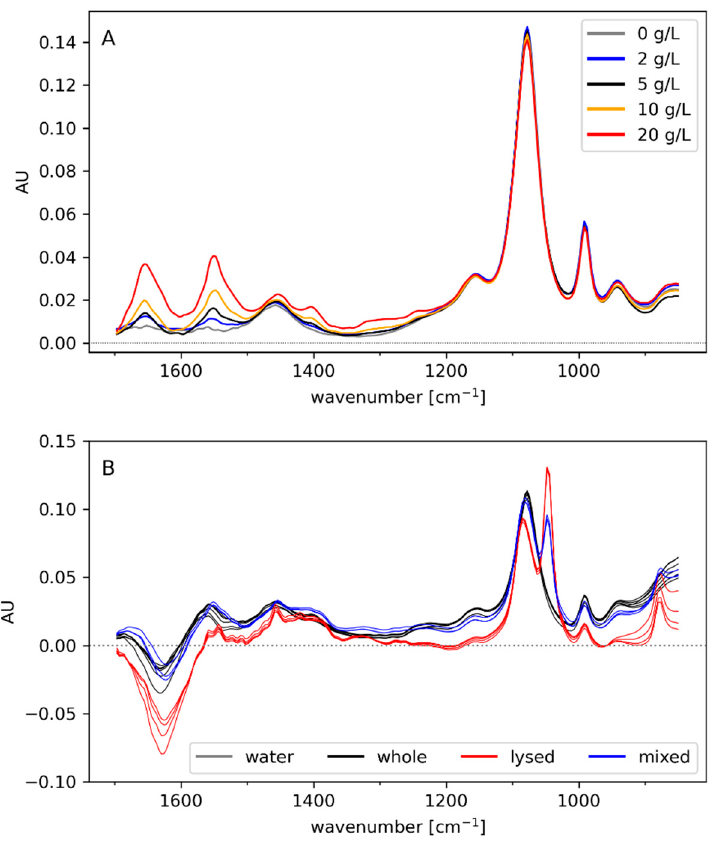
Figure 3. ( A ) Off-line spectra of varying concentrations of BSA in phosphate buffer (130 mM). ( B ) Off-line spectra of suspensions of whole cells, lysed cells, or a 1:1 mix of whole and lysed cells. Water was subtracted as background.